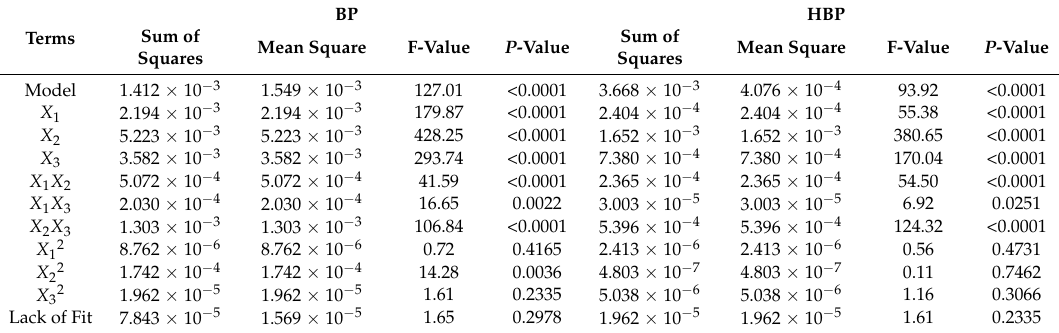
Table 3. Analysis of variance (ANOVA) for BP and HBP degradation